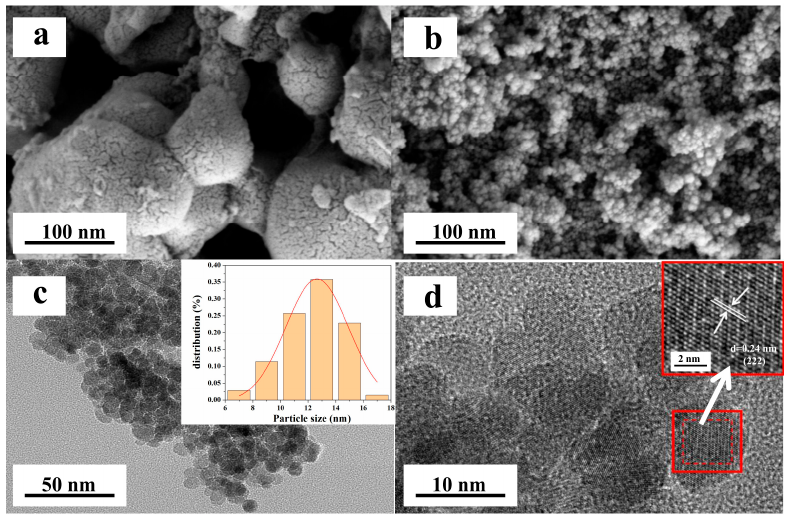
Figure 10. SEM images of SFBC ( a ) and Fe 3 O 4 @SFBC ( b ). TEM particle size distribution ( c ) and TEM lattice stripe ( d ) patterns of Fe 3 O 4 @SFBC.